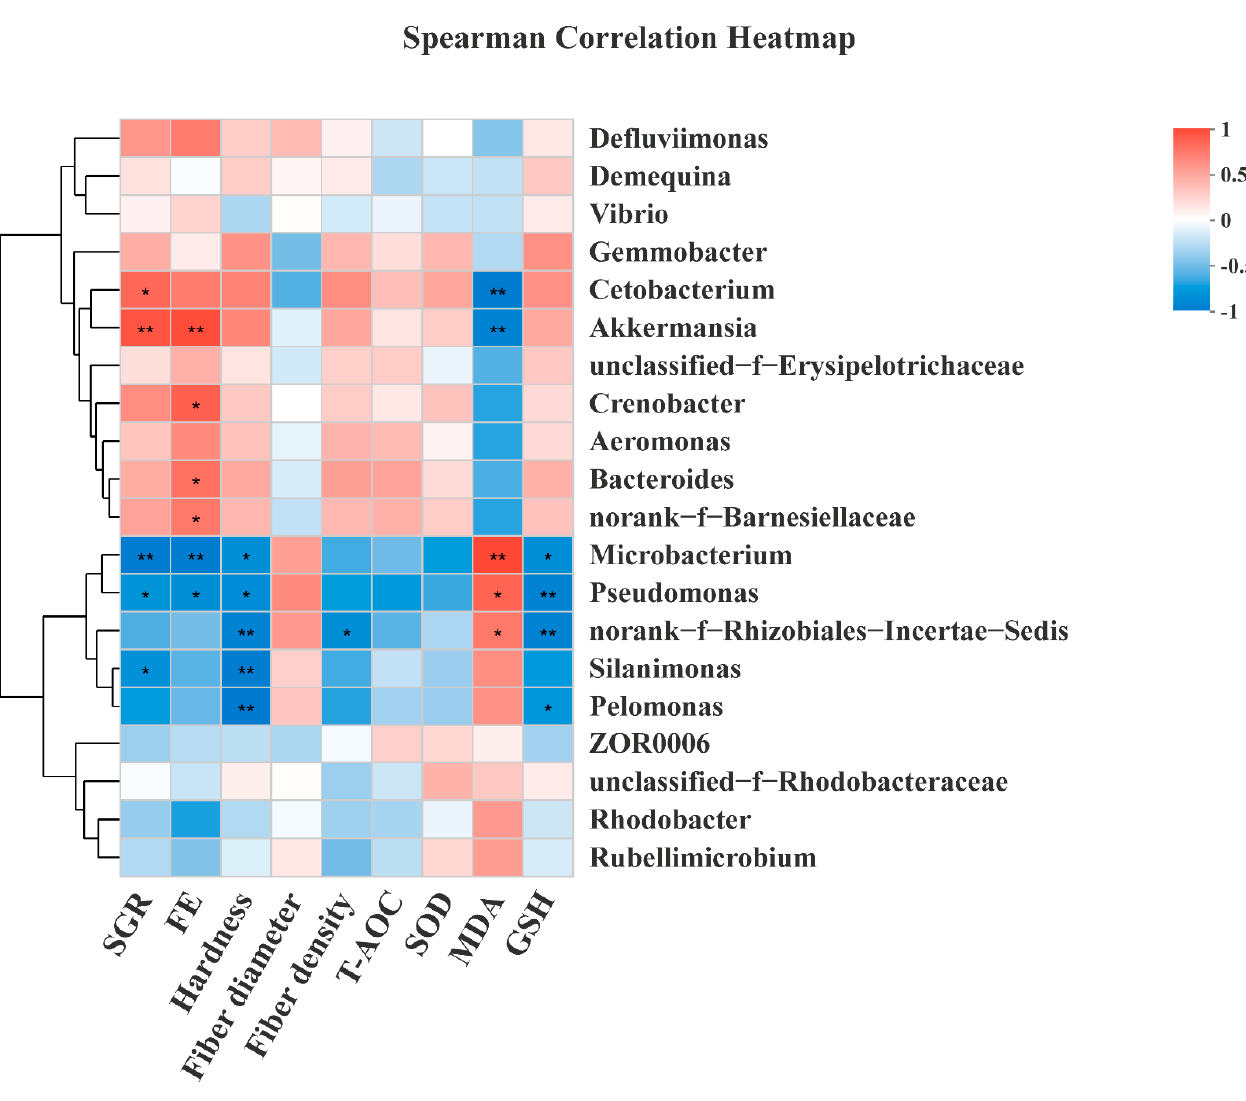
Figure 10. Correlation analysis of the intestinal microbiota and growth, muscle parameters. Spearman test, * p < 0.05, ** p < 0.01.